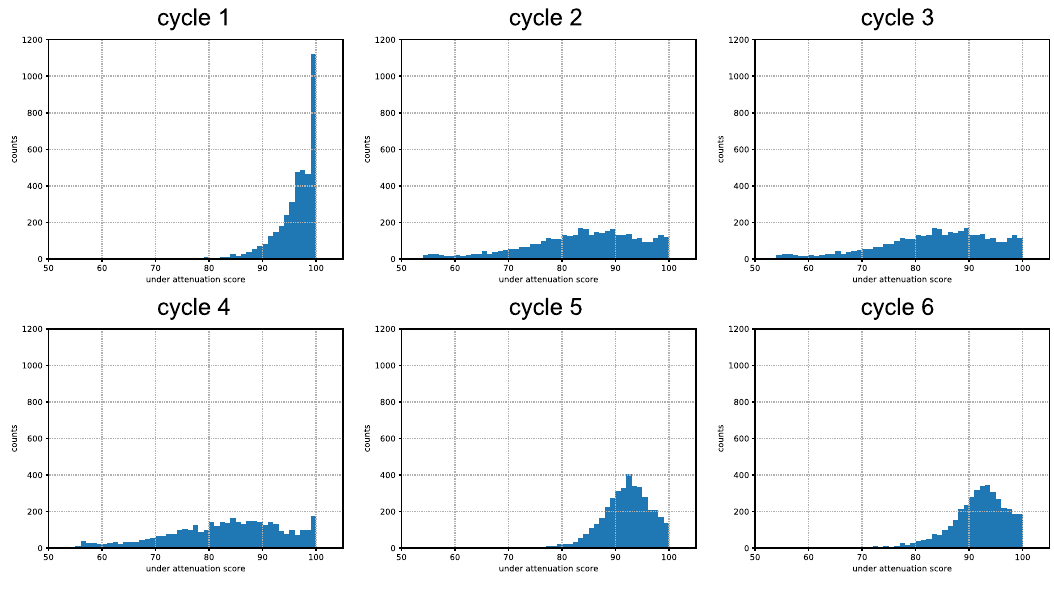
Figure 7. Histograms of over and under attenuation scores for each